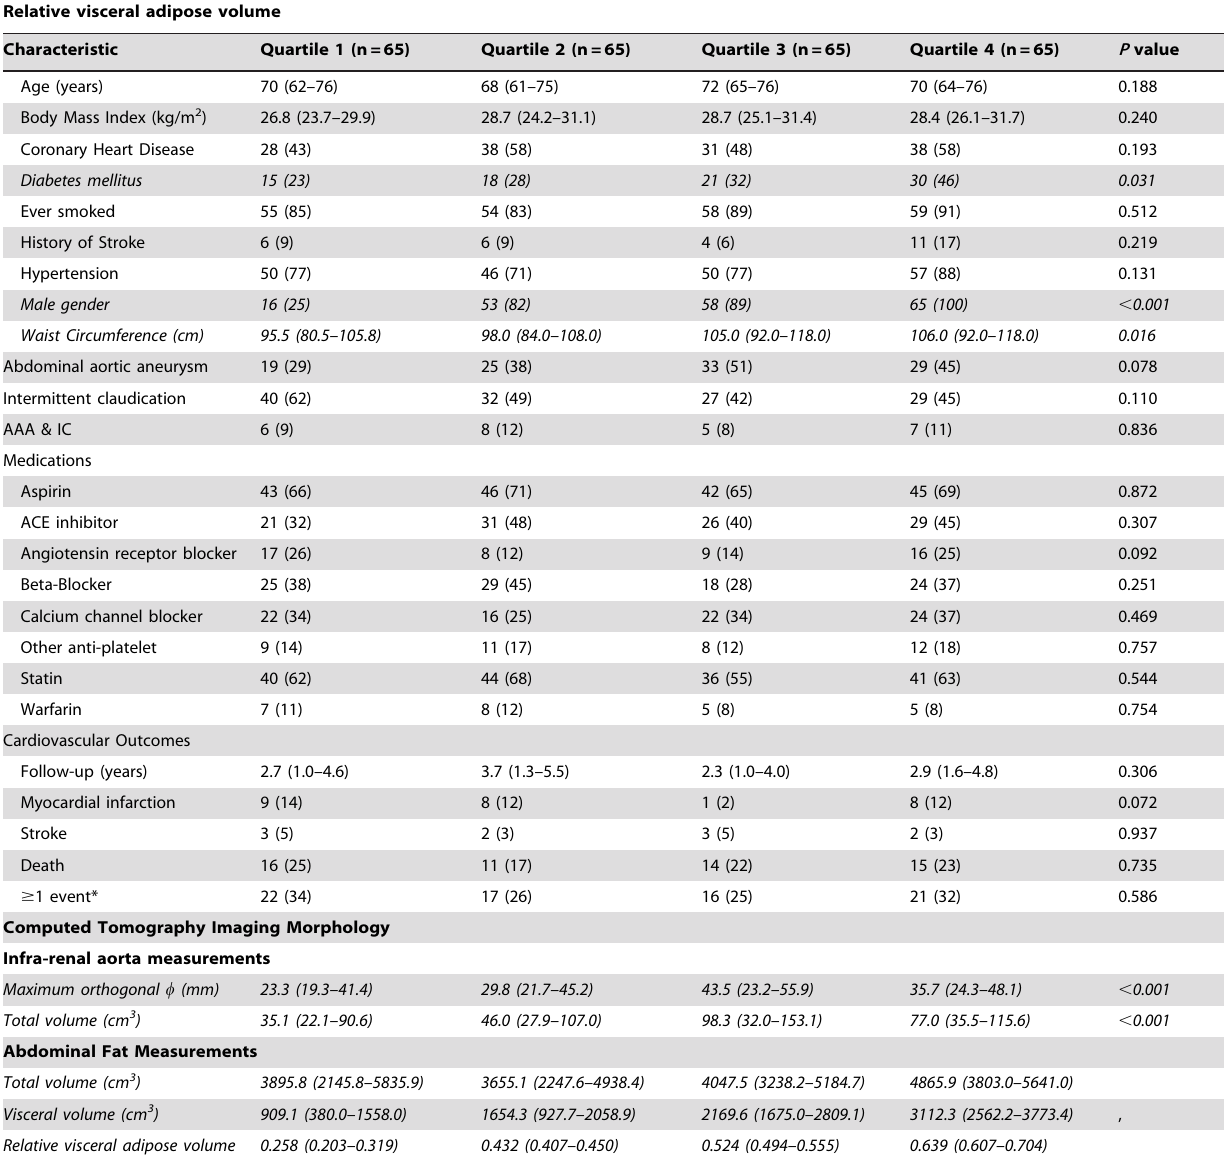
Relative visceral adipose